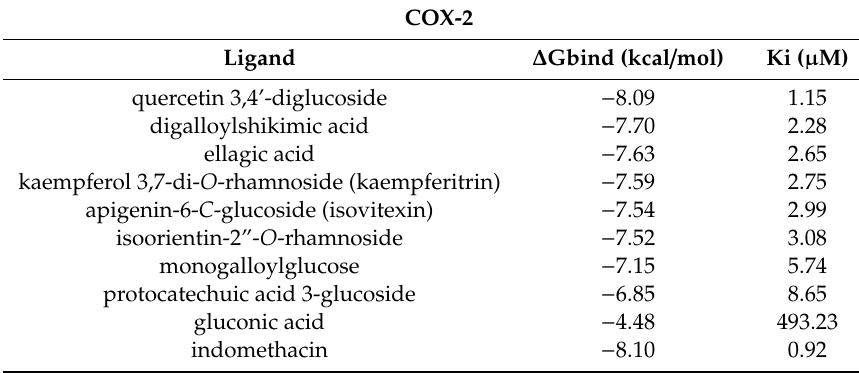
Table 4. Free-binding energies and inhibition constant obtained by molecular docking of the compounds identified in TbHPE with COX-2